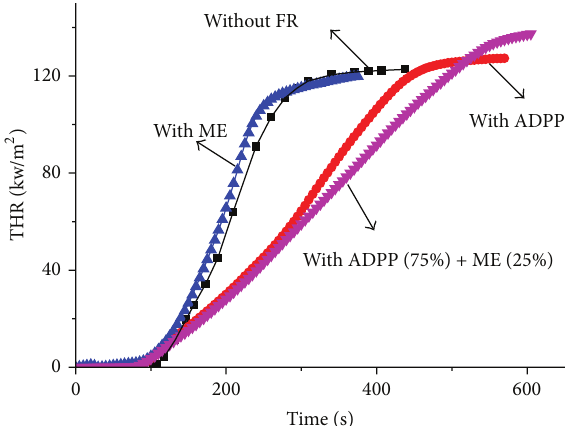
Figure 3: THR curves of PA6 and flame-retarded PA6.